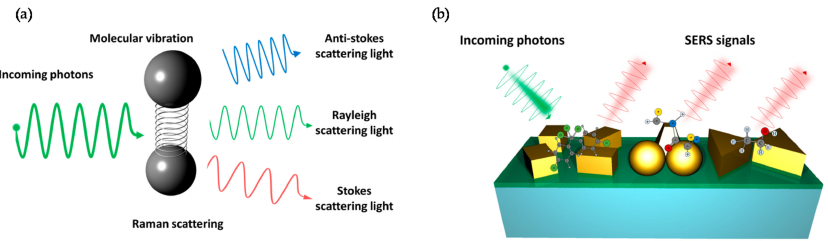
Figure 1. ( a ) The principle of Raman scattering; ( b ) Illustration of SERS sensing. Roughened metal surface or metallic nanostructures can enhance Raman signals and they can be applied to biological and chemical sensing.